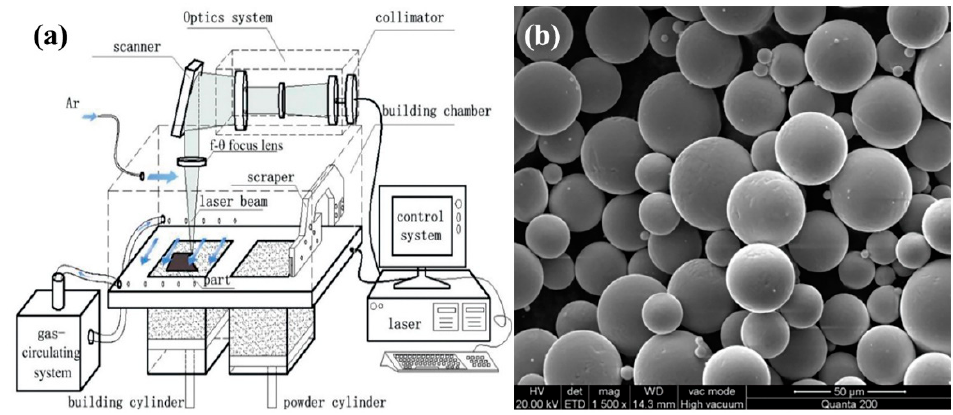
Figure 1. Principles, devices, and materials for selective laser melting (SLM)-based 3D metal printing: ( a ) illustration of SLM fabrication (reproduced from [21], with permission from Elsevier, 2018); ( b ) Ti-6Al-4V powder viewed by scanning electron microscopy (SEM).